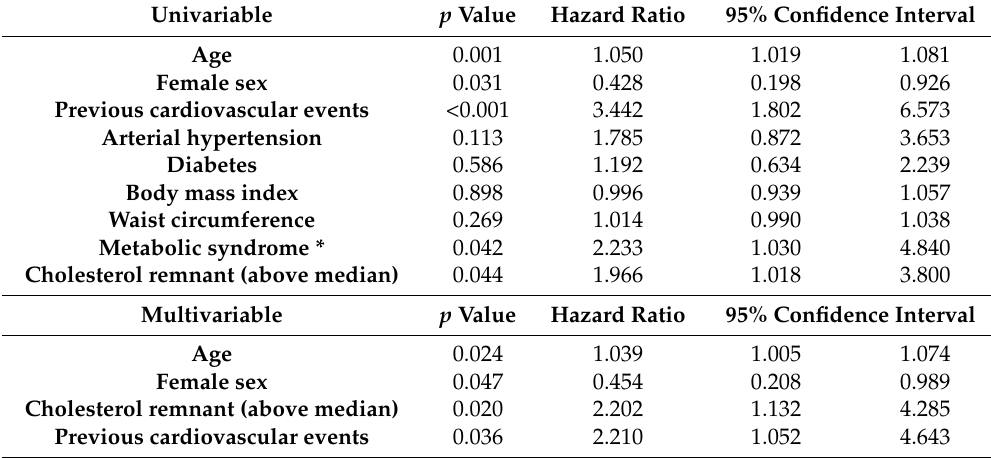
Table 3. Univariable and multivariable Cox proportional hazard regression analysis of factors associated with major cardiovascular and cerebrovascular events (MACCE) in patients with NAFLD. Univariable p Value Hazard Ratio 95% Confidence